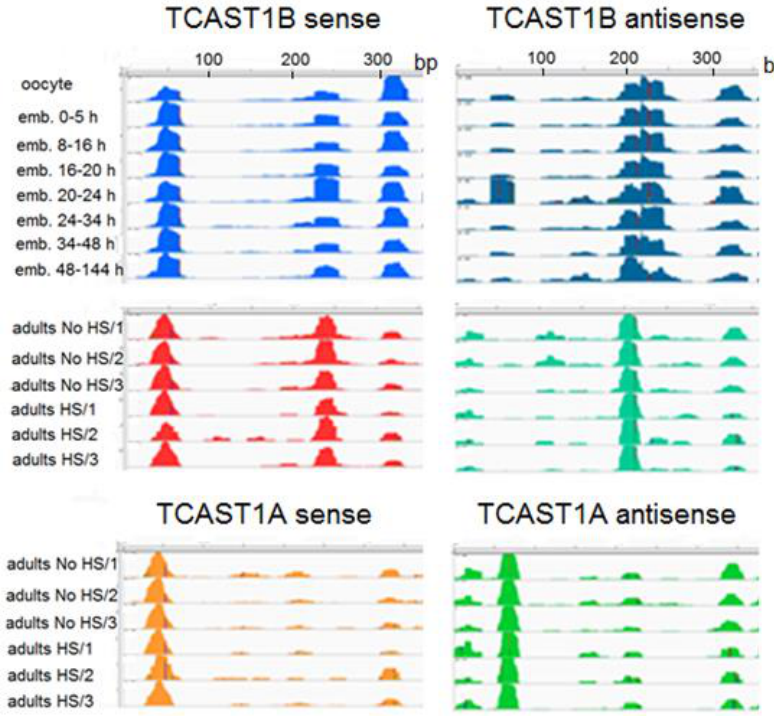
Figure 3. Distribution of piRNA and siRNA reads that map along the sense ( left ) and antisense ( right ) strand of the TCAST1B monomer (360 bp) during embryogenesis, and of siRNAs, which map along the sense ( left ) and antisense ( right ) strand of TCAST1B and TCAST1A monomers, respectively, in adults kept at normal temperature (No HS; in triplicate), as well as adults subjected to heat stress (HS; in triplicate).